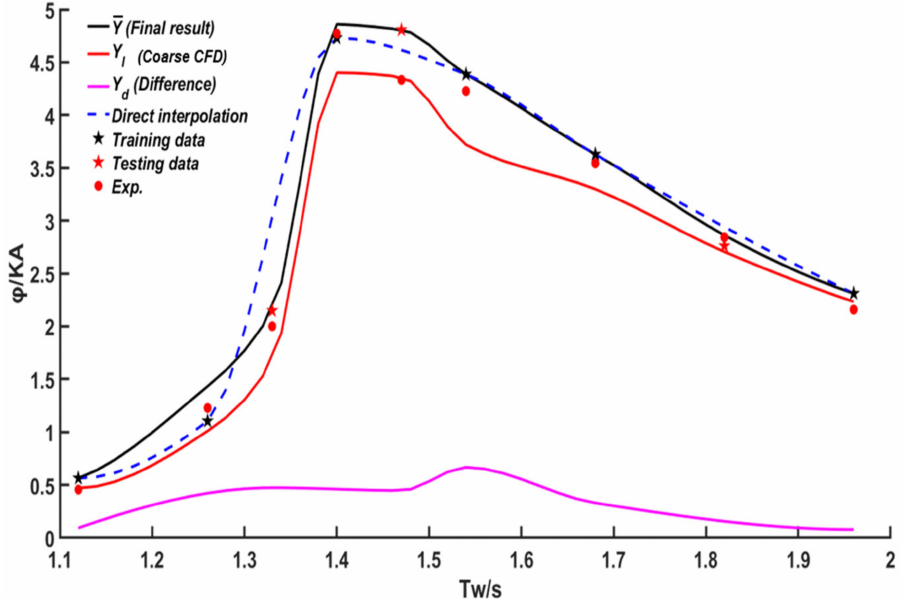
Figure 10. The performance of the proposed model for case no. 2 in Table